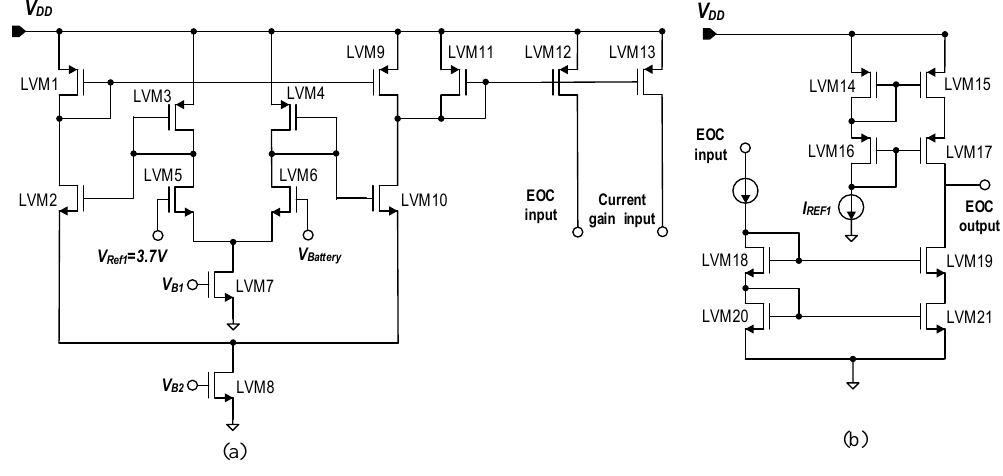
Figure 9. Schematic diagram of: ( a ) the implemented OTA; ( b ) the EOC detector.